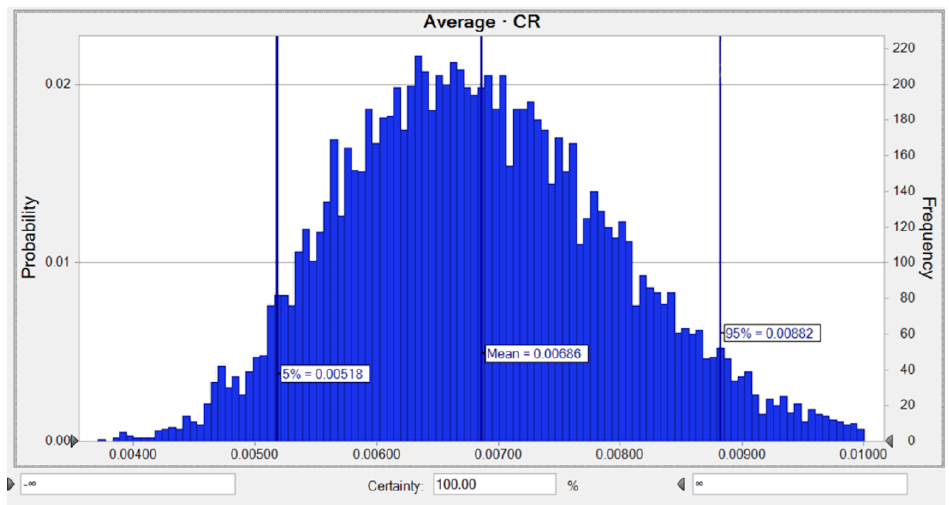
Figure 6. Predicted probability of TCR (adults) for As in water.